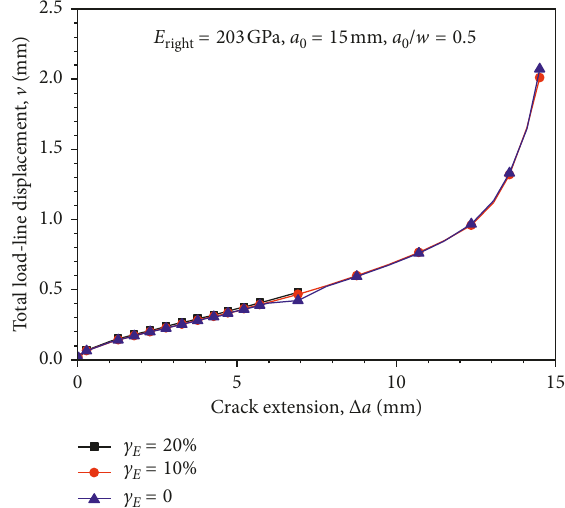
Figure 10: Applied displacement-crack extension curve of elastic modulus mismatch